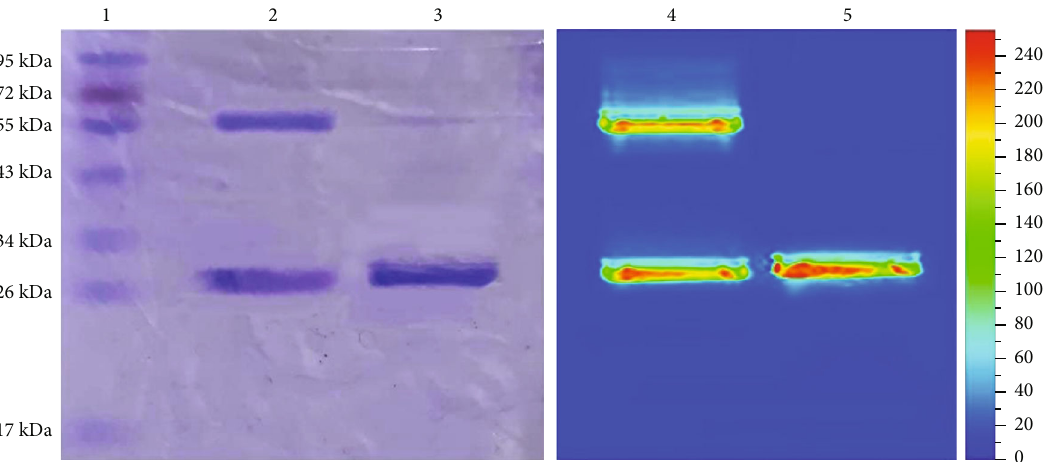
Figure 2: Characterization of IRDye800CW-labeled cet.Hum.scFv and cetuximab. SDS-PAGE image after Coomassie blue staining (lanes 1, 2, and 3 are protein ladder, cetuximab, and cet.Hum.scFv, respectively). The SDS-PAGE under near-infrared fi lter-equipped animal imaging system (lanes 4 and 5 are cetuximab and cet.Hum.scFv,